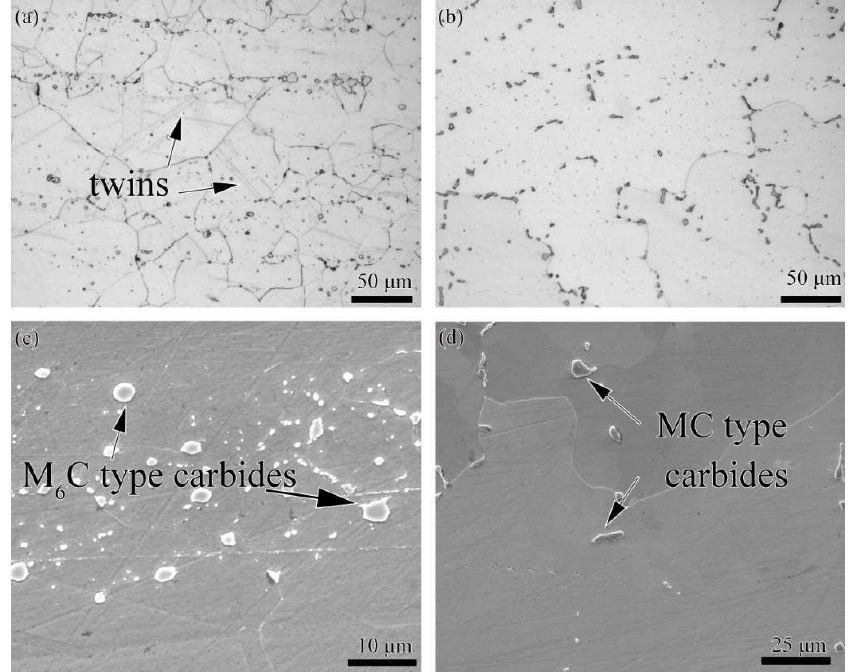
Figure 3. Microstructure of as-received base materials: ( a ) OM image of Hastelloy X alloy; ( b ) OM image of K4750 alloy; ( c ) SEM image of Hastelloy X; and ( d ) SEM image of K4750 alloy. Table 2. Compositions of carbides in the base metals (Atomic %).